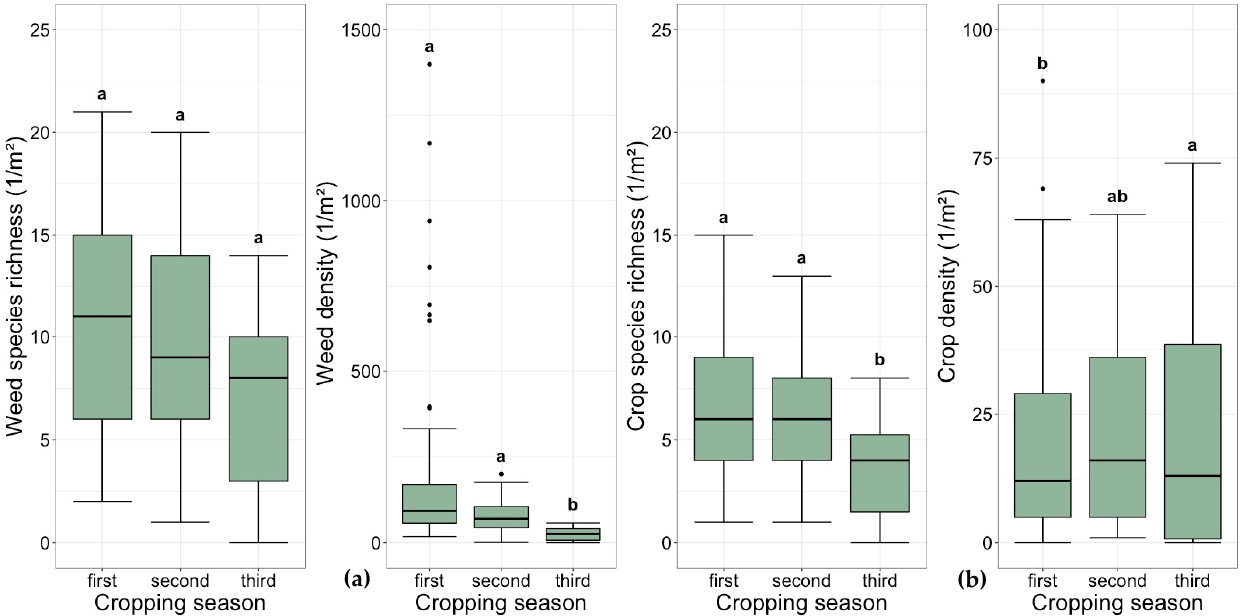
Figure 1. Boxplots of species richness and density of weeds ( a ) and crops ( b ) during the cropping seasons across all sites. The same letter means the difference is not significant (Tukey’s test). Sample size: first cropping season n = 96, second cropping season n = 64, third cropping season n = 32.